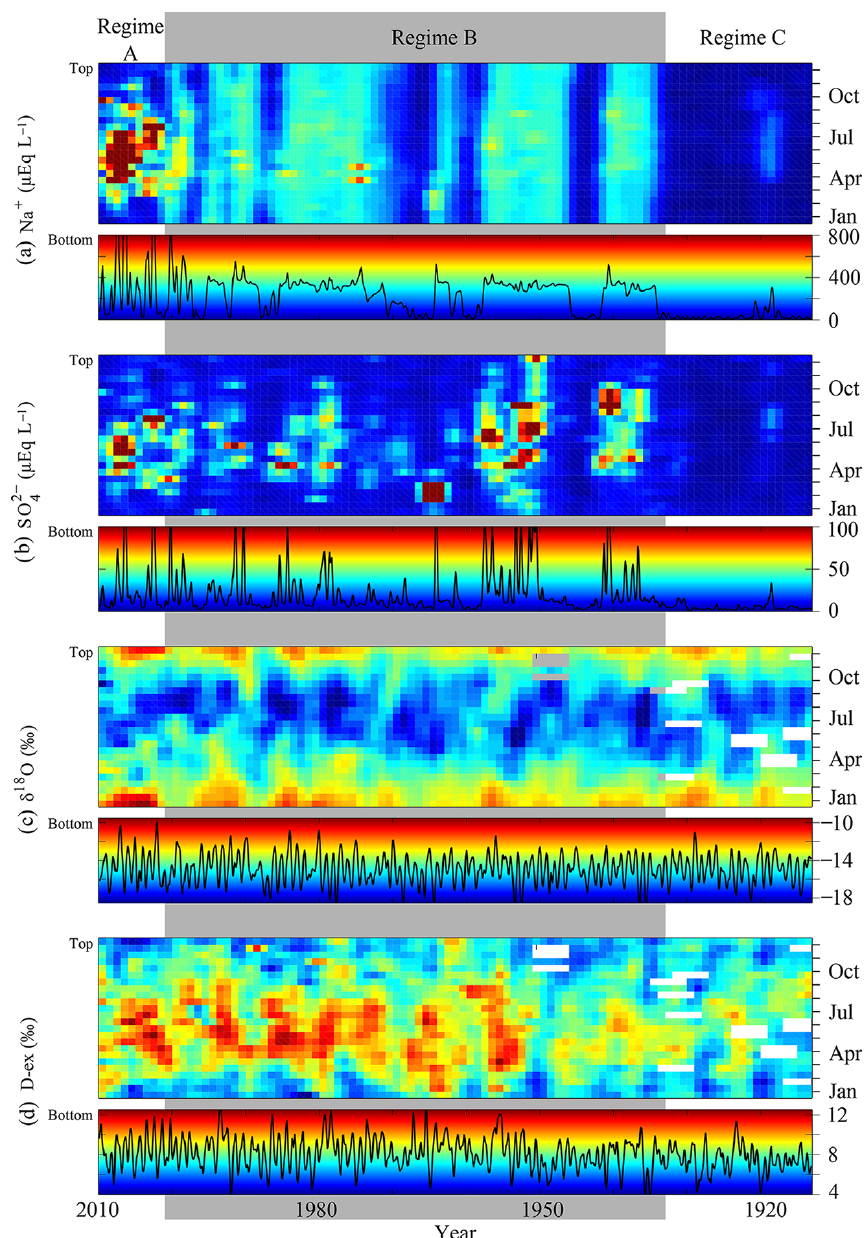
− concentrations, and (c) δ 18 O, and (d) D-ex ratios over the period from 1913 to 2009. Each top Figure 6. Time series of (a) Na + , (b) SO 2 4 panel: data were interpolated to 24 points per year, then smoothed with a Gaussian filter of width σ = 1 point. The x axis is year, the y axis is month, and colour scale is shown in each bottom panel. Each bottom panel: time series for each species from Figs. 2 and 4. The background colour indicates the colour used in the top panel. y axis is the concentration/ratio. Regime B (2000–1934) is shown using a grey panel to delineate the regime